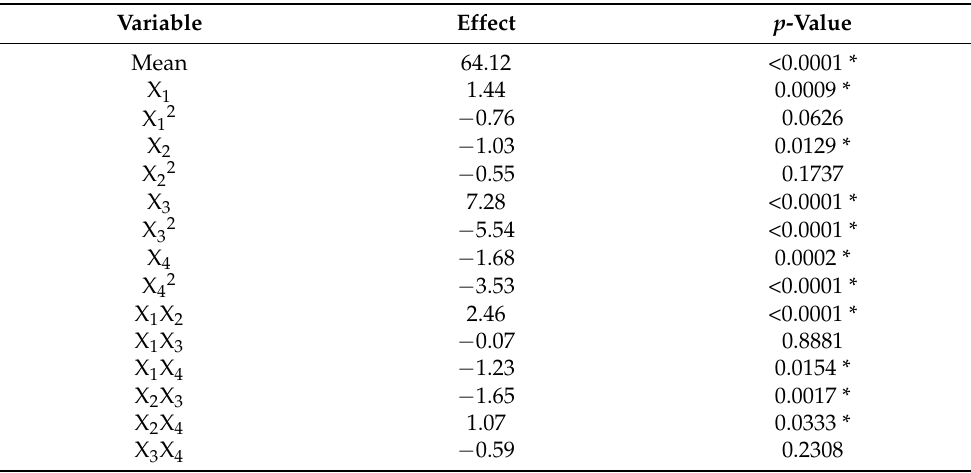
Table 2. Effects of the parameters of the central composite